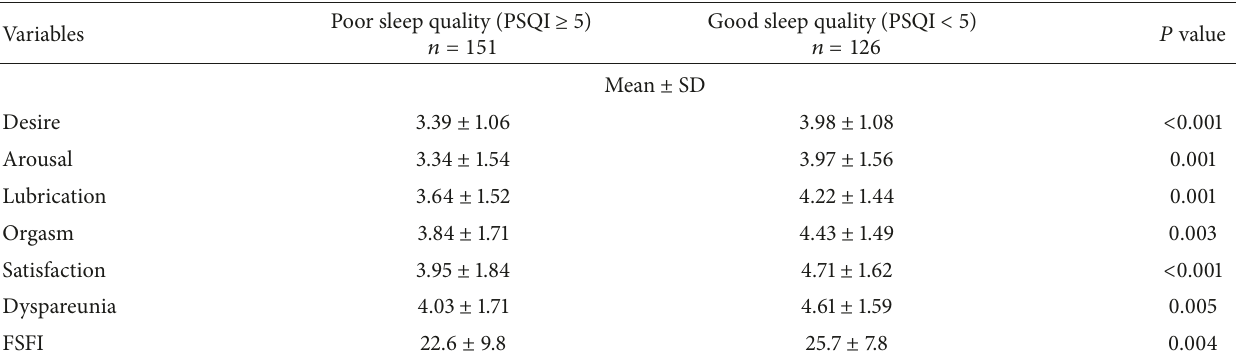
Table 2: Different domains of sexual activity in women with poor and good sleep